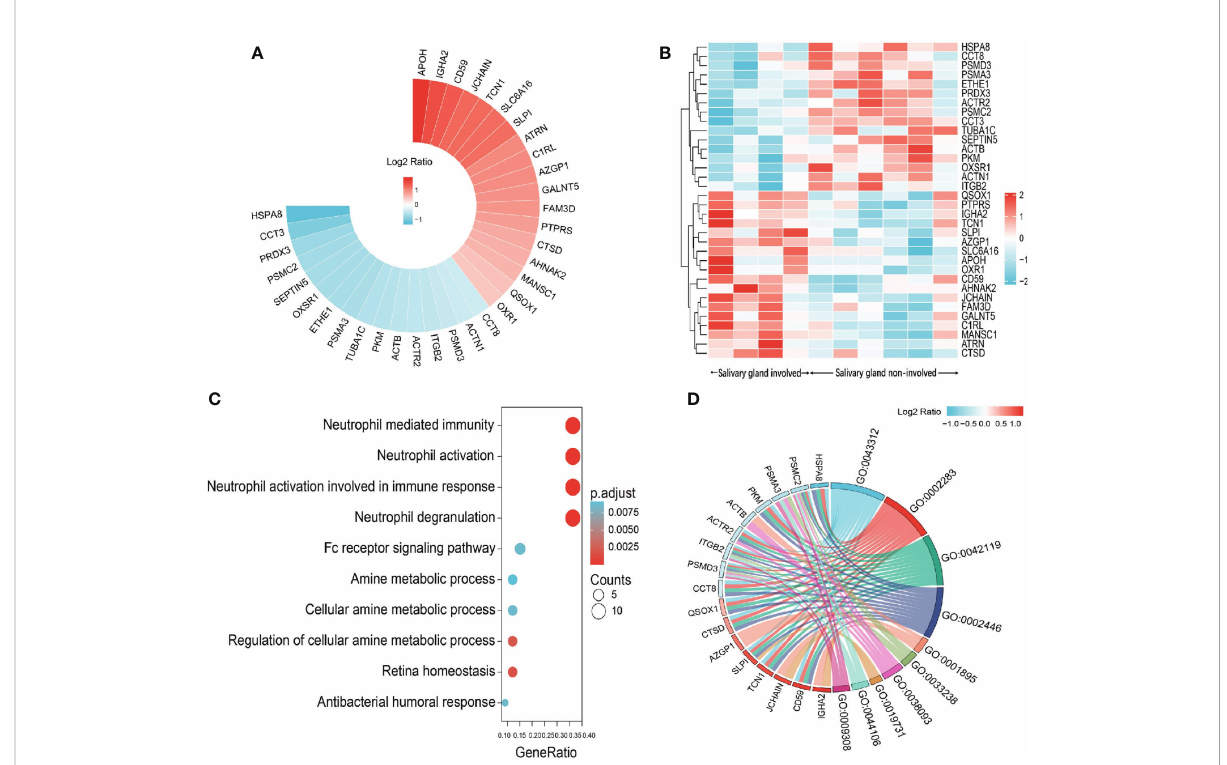
FIGURE 6 Summary of DEPs in the comparison between IgG4-RD patients with salivary gland involvement and without salivary gland involvement. (A) Circular heat map of upregulated and downregulated DEPs in the comparison between IgG4-RD patients with salivary gland involvement and without salivary gland involvement. (B) The expression heatmap of DEPs in IgG4-RD patients with salivary gland involvement and without salivary gland involvement. (C) Enriched GO category of DEPs in comparison of IgG4-RD patients with salivary gland involvement and without salivary gland involvement. (D) Chordal diagram of top ten GO categories in comparison of IgG4-RD patients with salivary gland involvement and without salivary gland involvement. The left half part is the gene color block and different color represents the corresponding gene Log2 Ratio values, the right half is the GO category color block, and the size of the color block represents the corresponding counts.